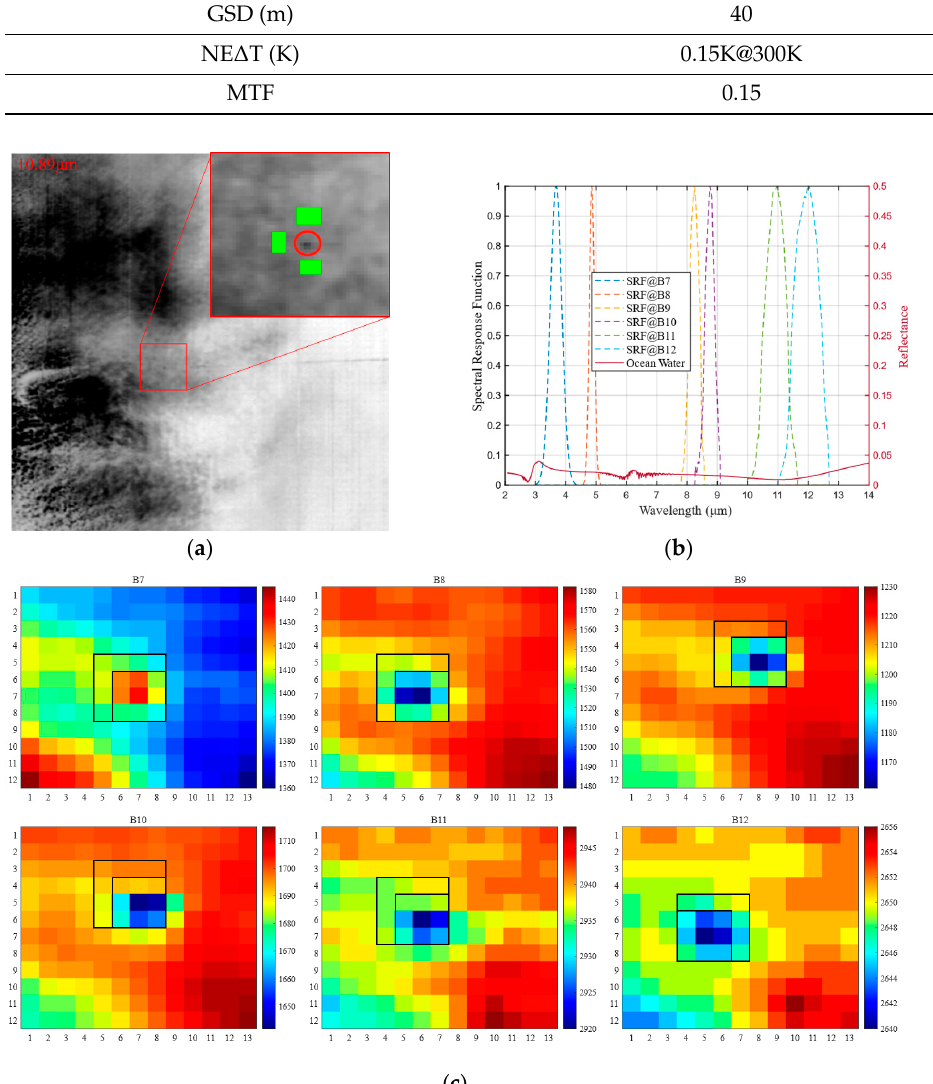
Figure 4. Auxiliary data for simulation, ( a ) aircraft position (red circle), the green box is selected cloud background area; ( b ) spectral response functions of B7–B12 and sea surface reflectance; ( c ) aircraft position and pixel aggregation information for B7–12 images. Table 2. Aircraft information.